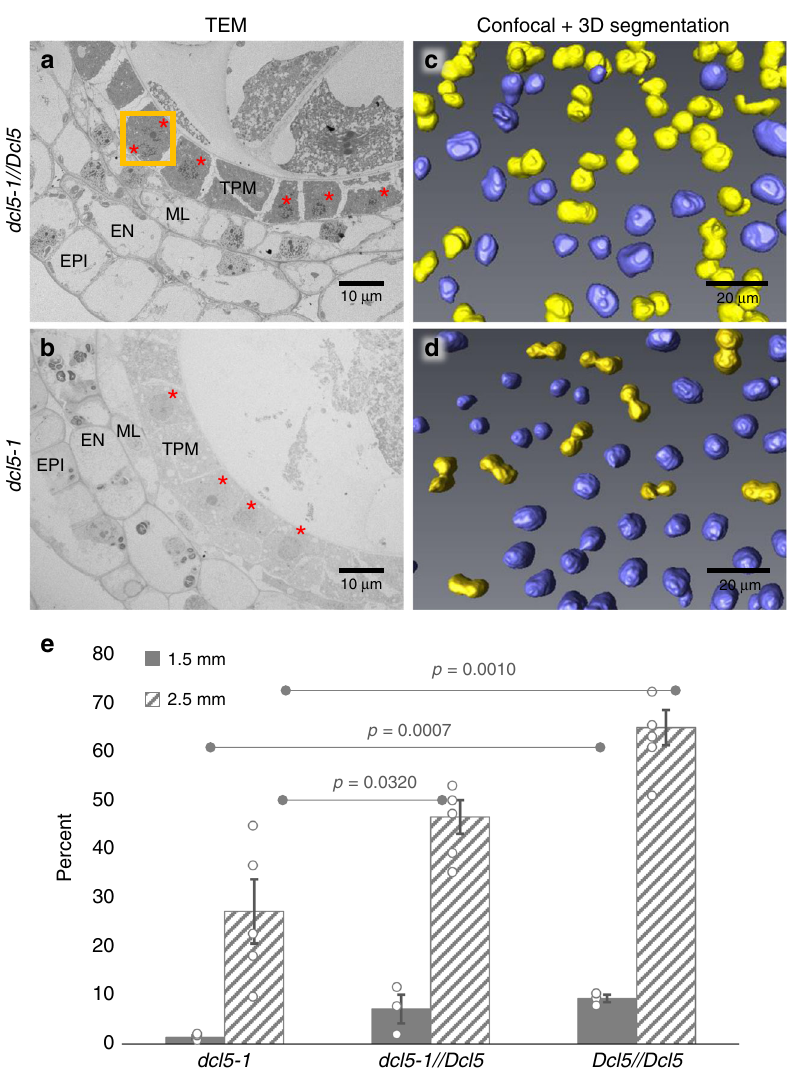
Fig. 2 Tapetal cells in dcl5-1 plants are delayed or arrested in achieving binucleate status. a Transmission electron microscopy (TEM) of a fertile dcl5-1// Dcl5 2.0 mm anther lobe. At this stage, the tapetal cells (TPM) are packed with dark staining materials, likely exine components later secreted onto haploid microspores. The middle layer (ML), endothecial (EN), and epidermal (EPI) cells are highly vacuolated. The orange boxes mark two binucleated tapetal cells in which both nuclei were visible (red dots). b TEM of a sterile dcl5-1 anther lobe at the same stage, demonstrating distended, pale-staining, and mononucleate tapetal cells. Two anthers as replicates from dcl5-1//Dcl5 and two anthers from dcl5-1 were used for TEM study. The other replicate is shown in Supplementary Fig. 8. c dcl5-1//Dcl5 , and d dcl5-1: three-dimensional reconstructions of cleared, 2.5 mm anthers stained with the nuclear marker Syto13. Individual nuclei of mononucleate tapetal cells are marked in purple, and binucleated cells are marked in yellow. e Quanti fi cation of binucleated cells in dcl5- 1 , dcl5-1//Dcl5 , and Dcl5//Dcl5 siblings at the meiotic I (1.5 mm) and meiotic II (2.5 mm) stages, in a family segregating 1:2:1. Statistics: two-tailed Student ’ s T -test. Three replicates were used for 1.5 mm anthers of each genotype; fi ve replicates were used for 2.5 mm anthers of each genotype. Gray dots represent individual replicates (see Source Data File). Error bars indicate standard error of the mean